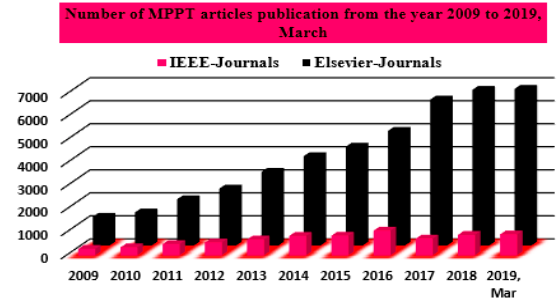
Figure 1. Number of maximum power point tracking (MPPT) articles published annually [27].